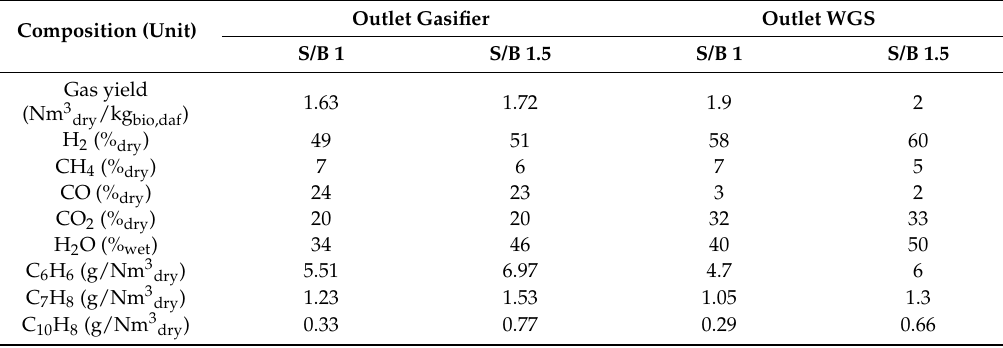
Table 10. Syngas composition in outlet of gasifier and inlet of